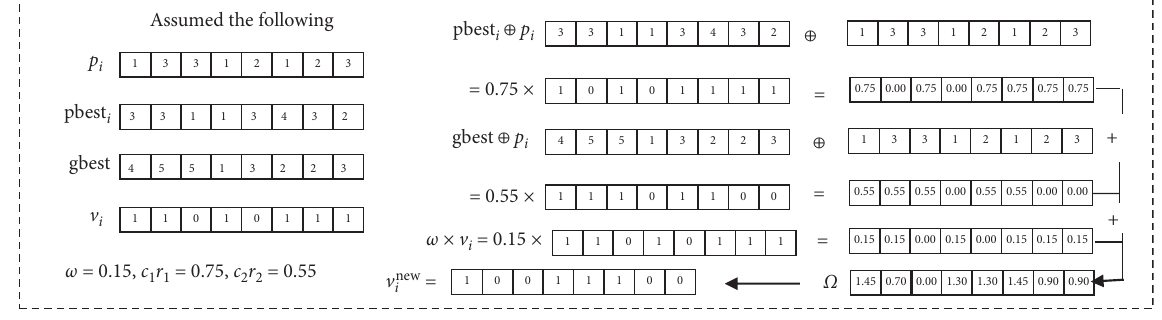
Figure 4: Demonstration of new velocity